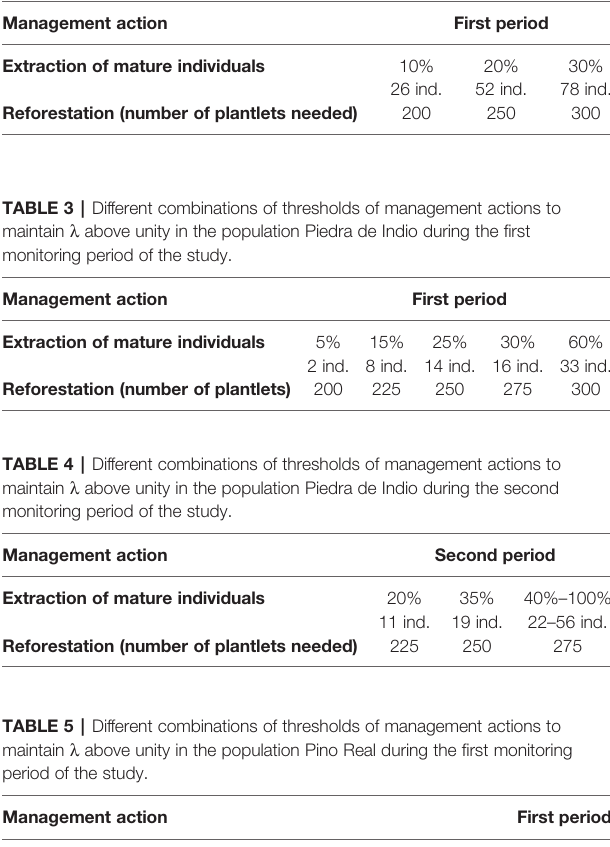
TABLE 2 | Different combinations of thresholds of management actions to maintain l above unity in the population Cuanajo during the fi rst monitoring period of the study.